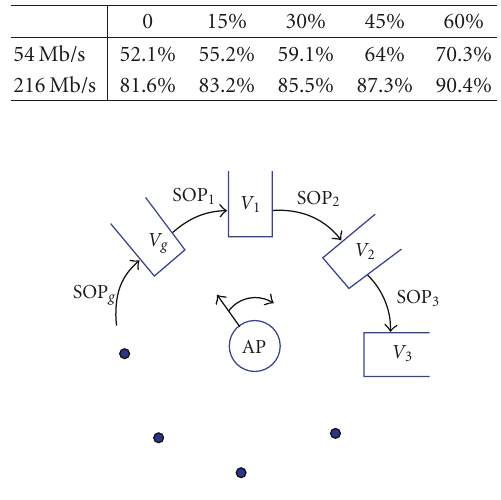
Figure 2: Token distribution model in TMAC.